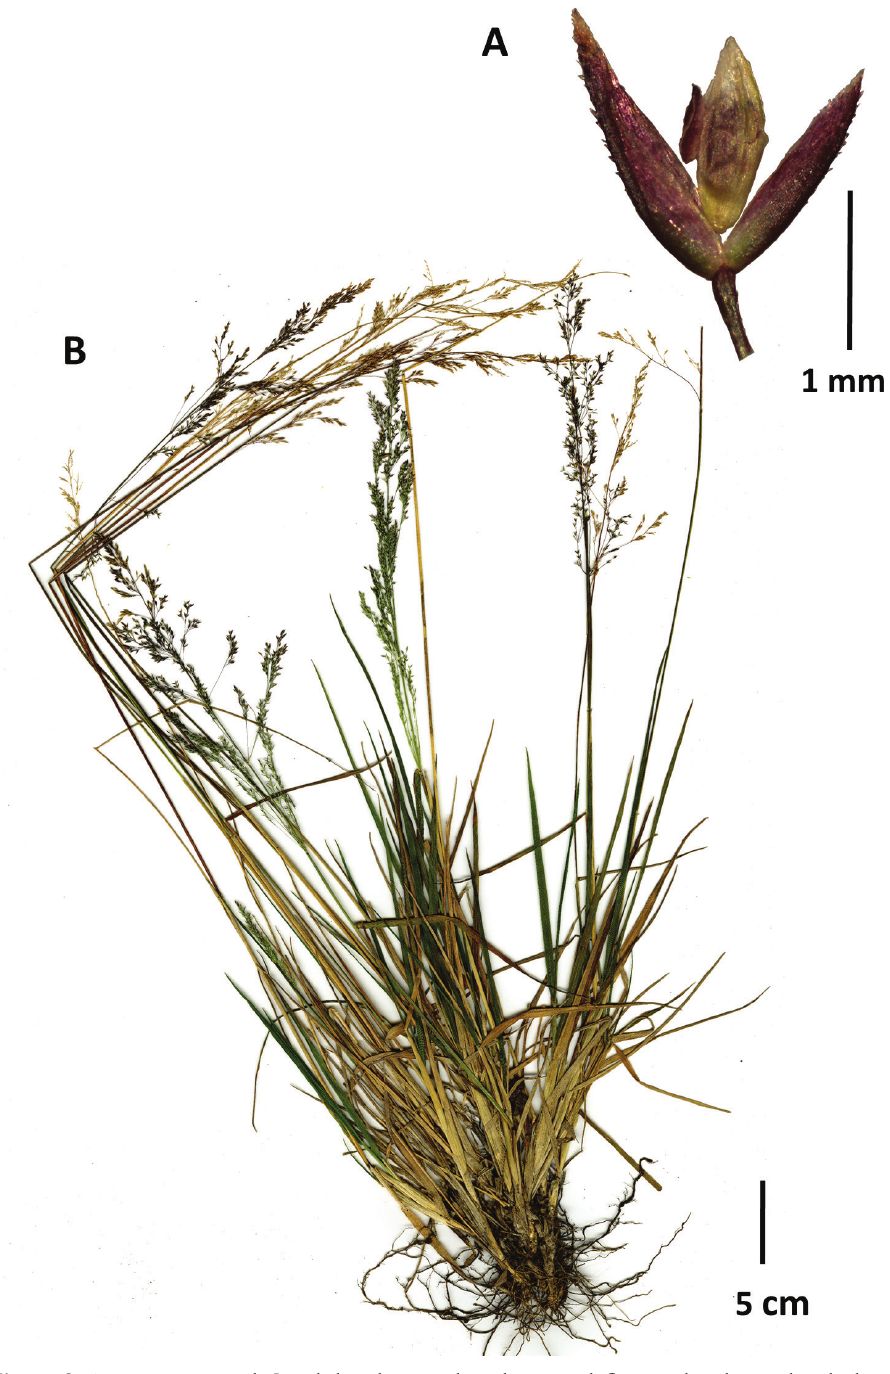
Figure 8. Agrostis perennans s.l. A spikelet, glumes in lateral view, with floret in dorsal view, detached and raised slightly above the glumes B whole plant. Images of Vorontsova 2247